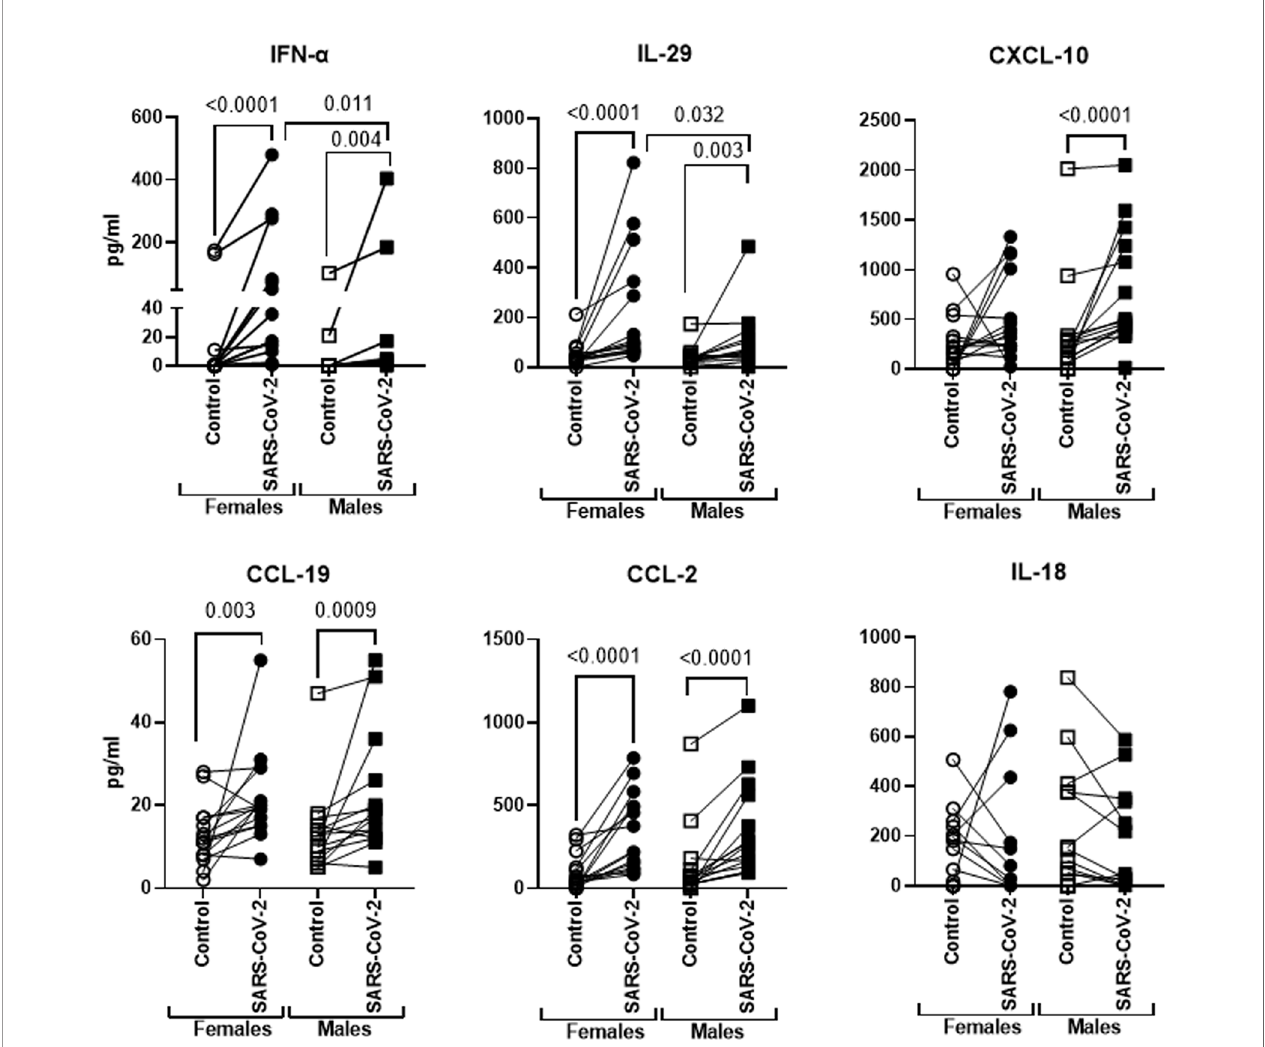
FIGURE 4 | Differential cytokine/chemokine secretion in males and females in response to SARS-CoV-2. PBMCs were stimulated o/n with irradiated SARS-CoV-2 virus for 24 h. Graphs depict the quantitation of cytokines/chemokines in the supernatant by multiplex. Lines connect the unstimulated and stimulated conditions from the same subject. Mean ± SE. Females = 15; males = 15. p -value between the control and SARS-CoV-2-stimulated condition in males and females was calculated using Wilcoxon matched pairs signed rank test. Signi fi cance between males and females was calculated using unpaired t -test (Mann – Whitney